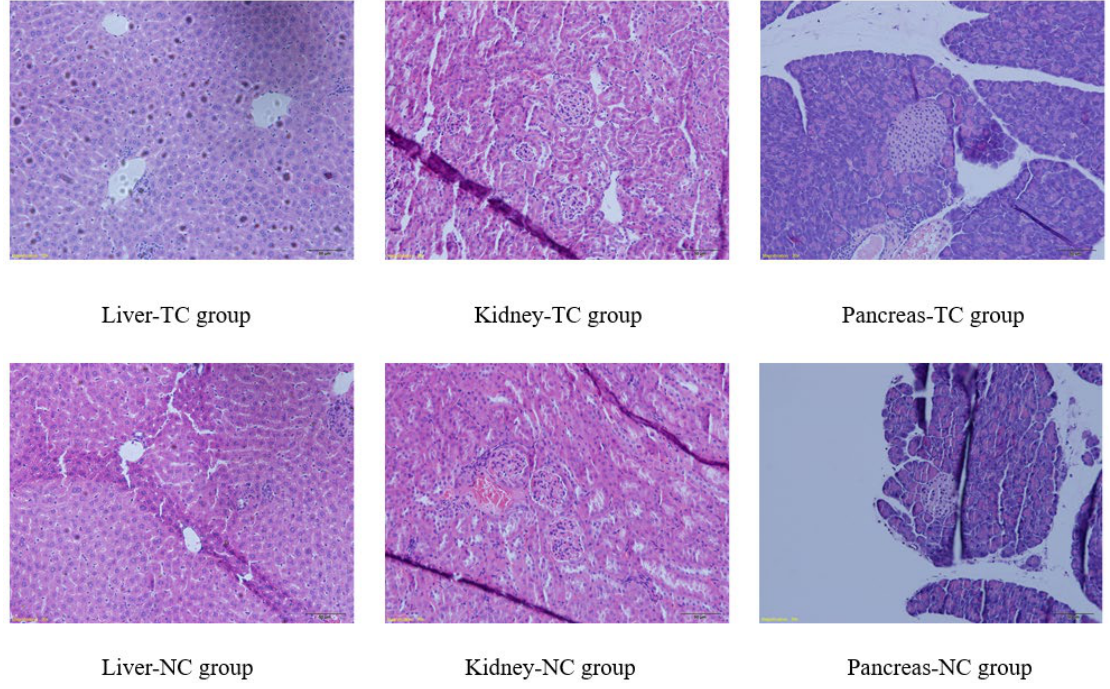
Figure 16. Effects of [CrBCA 3 ] on the body mass of the mice in sub-acute toxicity study. Values are means ± SD ( n = 10). Table 7. Organ indices of mice in each group (means ± SD, n = 10).